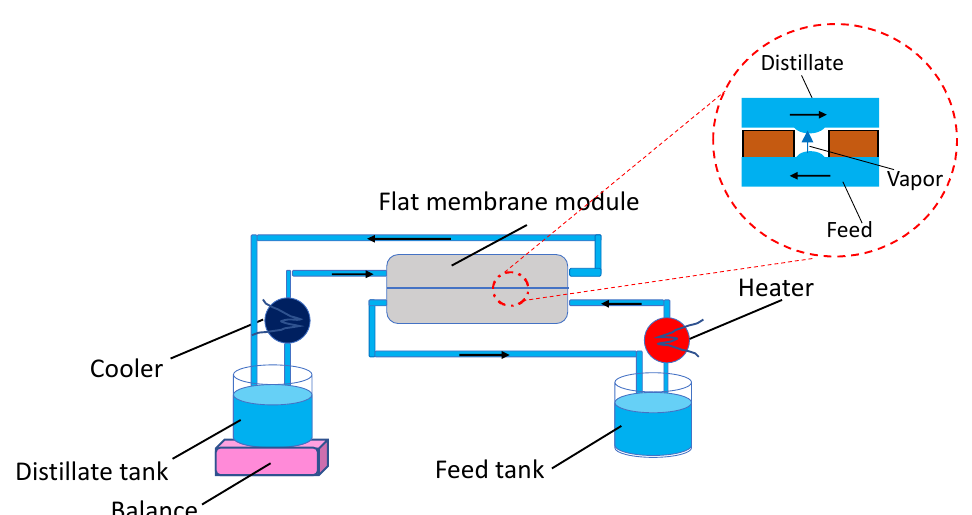
Energies 2021 , 14 , x FOR PEER REVIEW Figure 1. Scheme of the DCMD lab set-up and sketch of the vapor transport through a micropore.